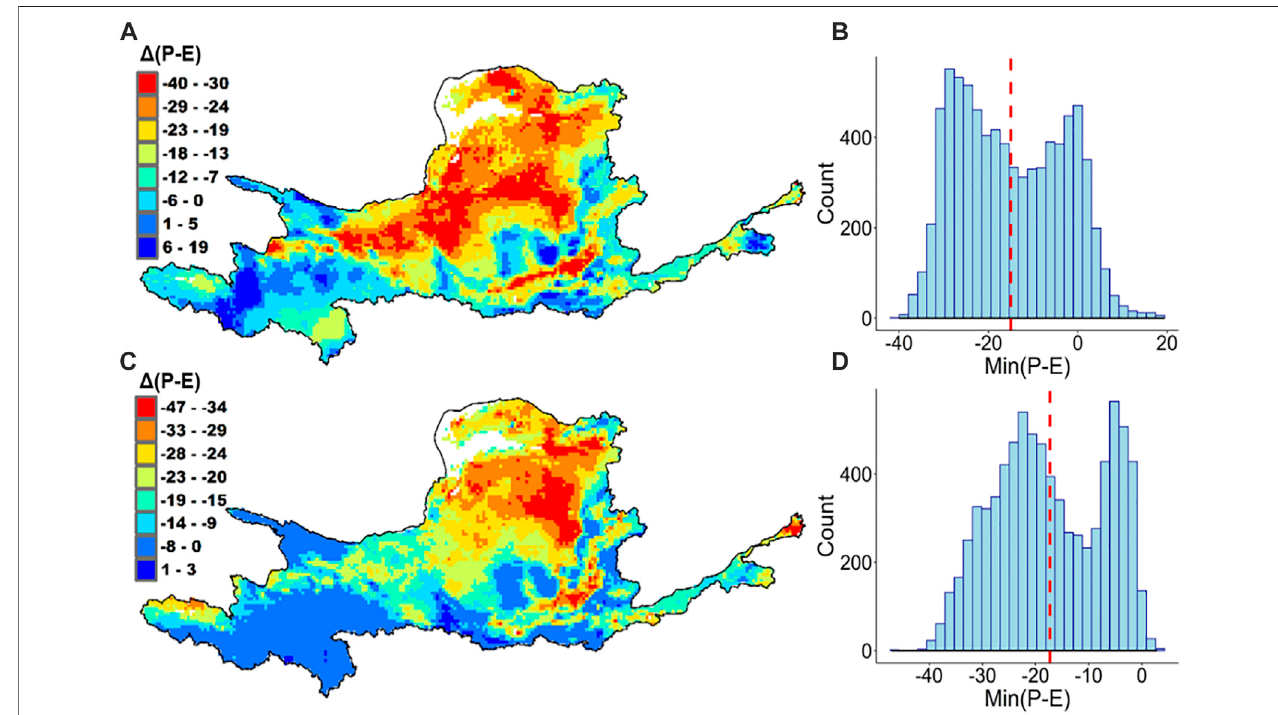
FIGURE 2 | Contributions of P and E changes to Δ min(P – E) (dry-season water availability). (A,B) Spatial pattern of Δ P contribution to Δ min(P – E) and its corresponding density distribution. (C,D) Spatial pattern of Δ E contribution to Δ min(P – E) and its corresponding density.